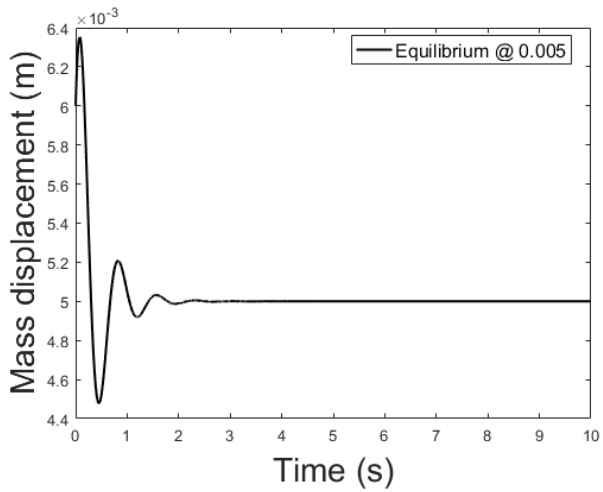
Figure 14. Observer controlled system output with equilibrium at x = 0.005.